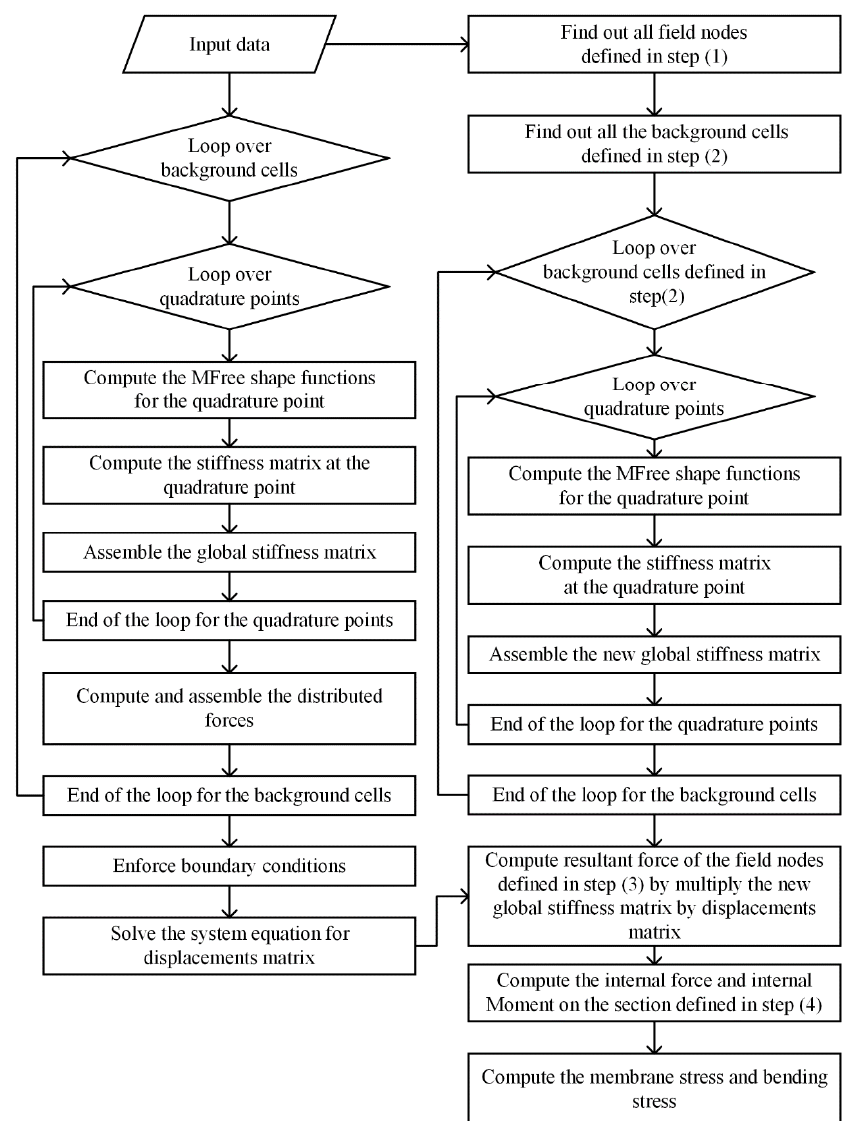
Figure 4. Flowchart of obtaining the stress solutions of improved radial point interpolation method (RPIM).